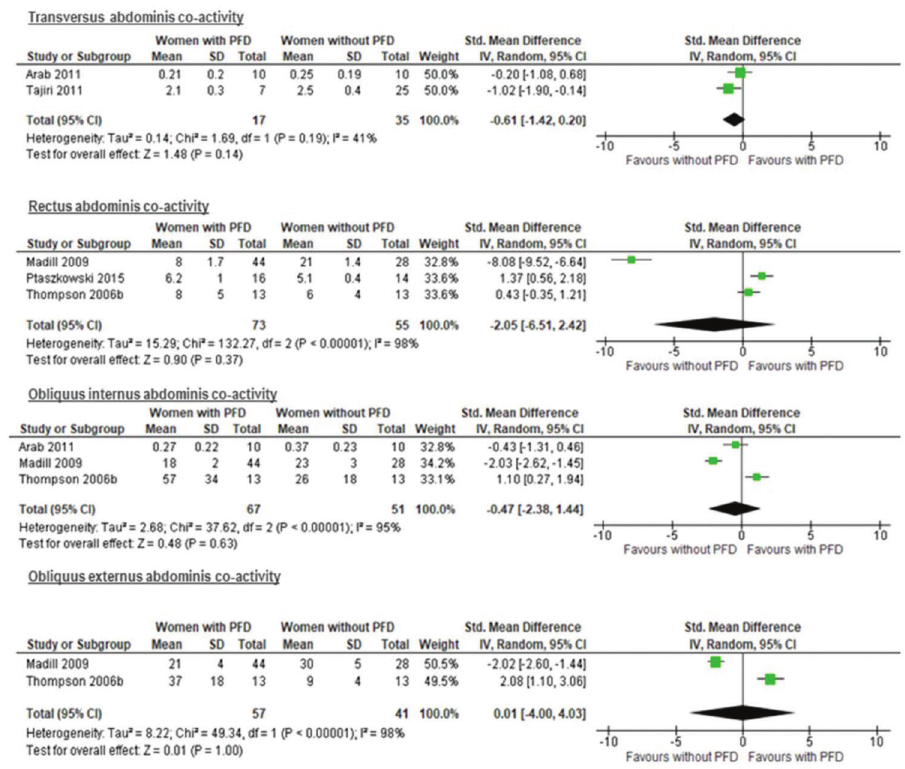
Figure 3 - Forest plot showing the co-activity of the transversus abdominis, rectus abdominis, obliquus internus and obliquus externus muscles during maximal pelvic floor muscle contraction. CI = Confidence interval; PFD = Pelvic floor